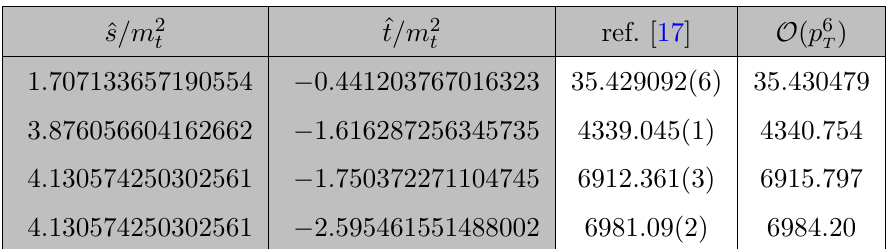
Table 2 . Comparison of V fin 4 / ( α 2